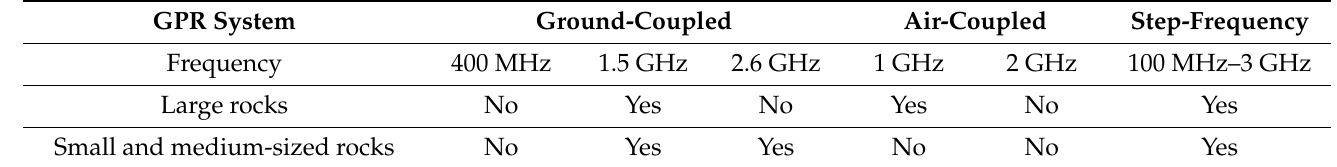
Table 2. Summary of GPR measurements recommendation under certain situation according to [33].